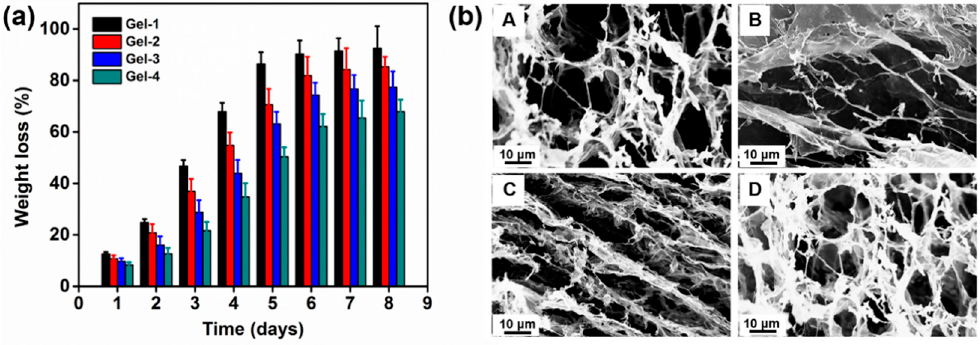
Figure 6. ( a ) Weight loss of the hydrogels in the presence of trypsin at a concentration of 0.1 mg/mL in the PBS solution as a function of time. Black bar: Gel-1; red bar: Gel-2; blue bar: Gel-3; green bar: Gel-4. ( b ) SEM of the hydrogel after 4 days biodegradation in the PBS at the trypsin concentration of 0.1 mg/mL (A: Gel-1; B: Gel-2; C: Gel-3; D: Gel-4).